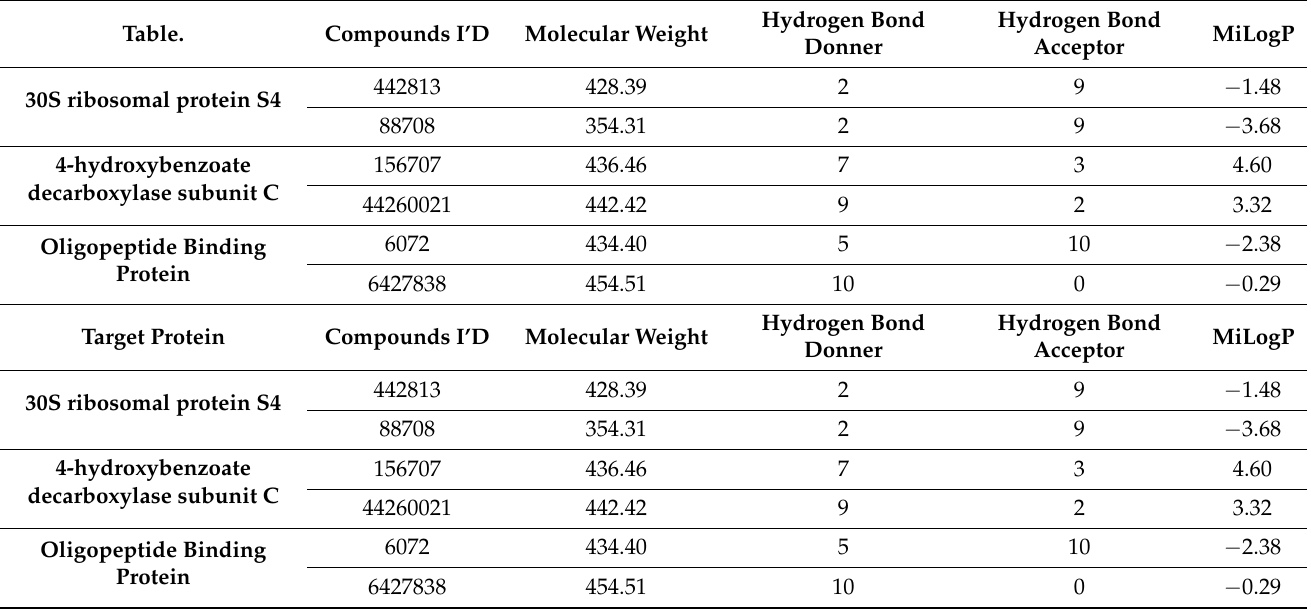
Table 4. The top six phytochemicals were determined following Lipinski’s Rule of Five molecular properties and drug-likeness. Table.